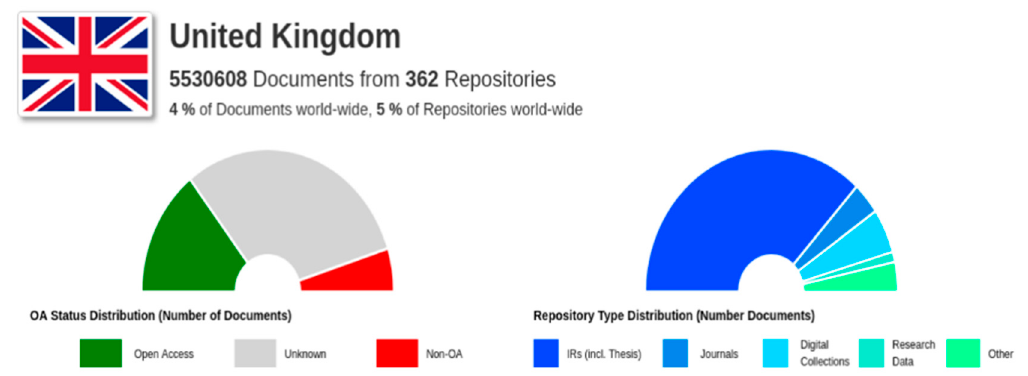
Figure 5. The national repository network profile for the UK, displaying some basic information such as number of documents and repositories, OA status and repository type distribution.